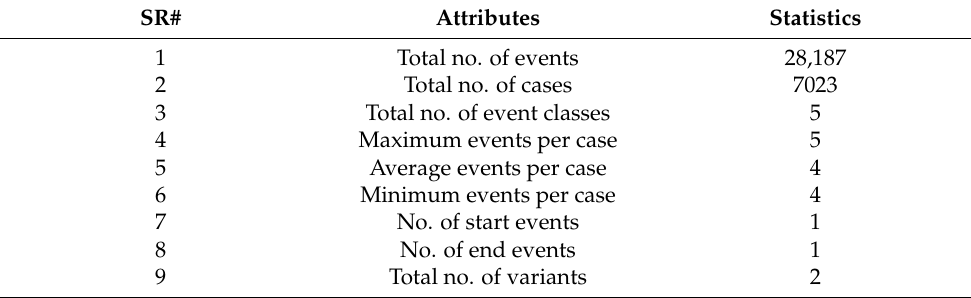
Table 9. Statistics of log data after removal of noise.